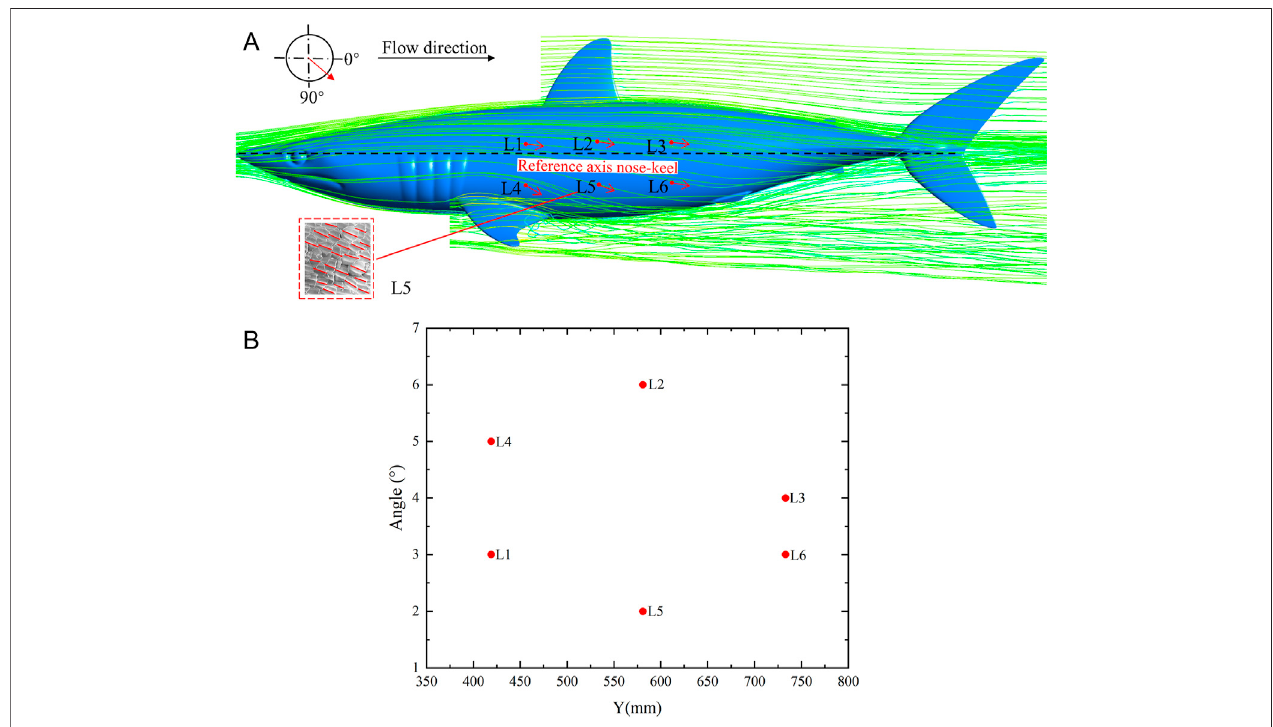
FIGURE7 | Streamlines ofthe fl ow fi eld around the shark and the scale riblets angle along the fl ow direction in thecruising attitude. (A) Streamlines ofthe fl ow fi eld andtheorientationofangles, (B) Thevaluesoftheangles.Thearrowsindicatetheangleofscaleribletsinrelationtothestreamlineasshownintheupperleftscheme.The trend of the scale riblet of sample L5 is shown in the lower left corner. The longitudinal reference axis is from nose to caudal fi n keel of the short fi n mako shark.